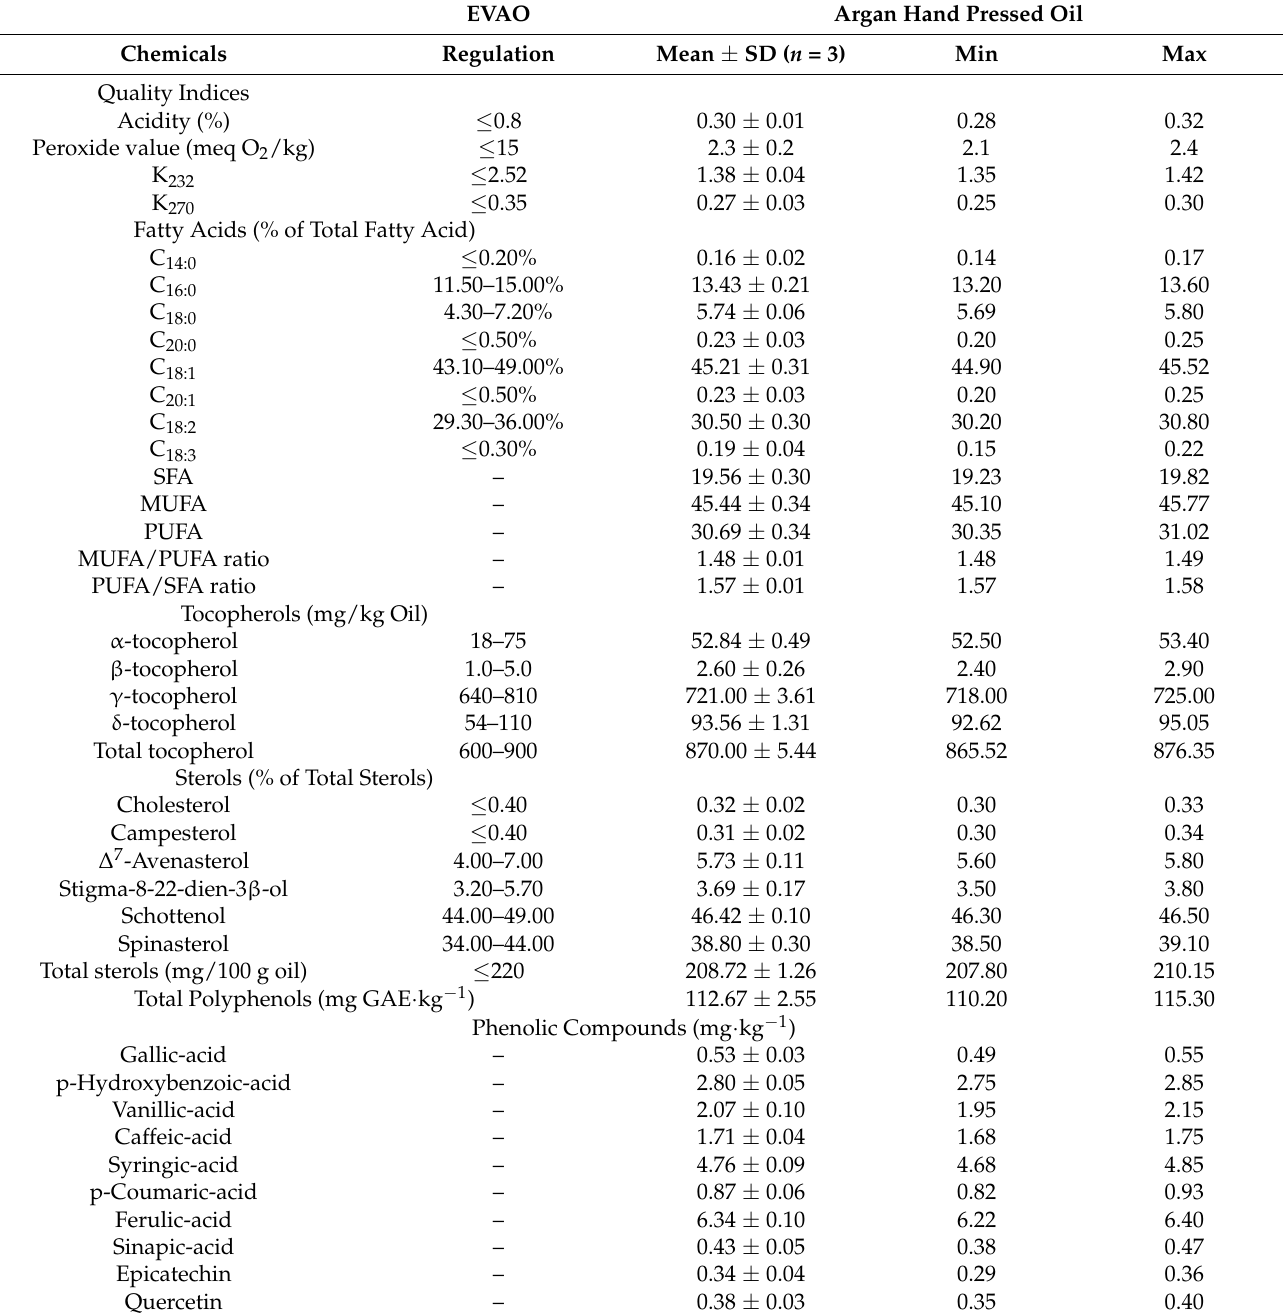
Table 2. The chemical composition of hand pressed Argan oil showed as mean ± standard deviation (SD). EVAO Argan Hand Pressed